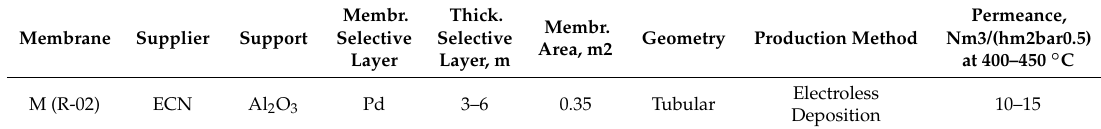
Table 1. Main characteristics of membranes installed in R-02.